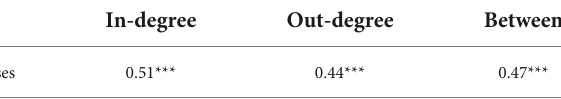
interpersonal self-efficacy were more popular with others. The correlation coefficient between interpersonal self-efficacy and betweenness centrality indicates that individuals with high interpersonal self-efficacy not only had a relatively large-scale friendship network, but were also more likely to become intermediaries in the process of making friends. Hypothesis 4 had been verified.